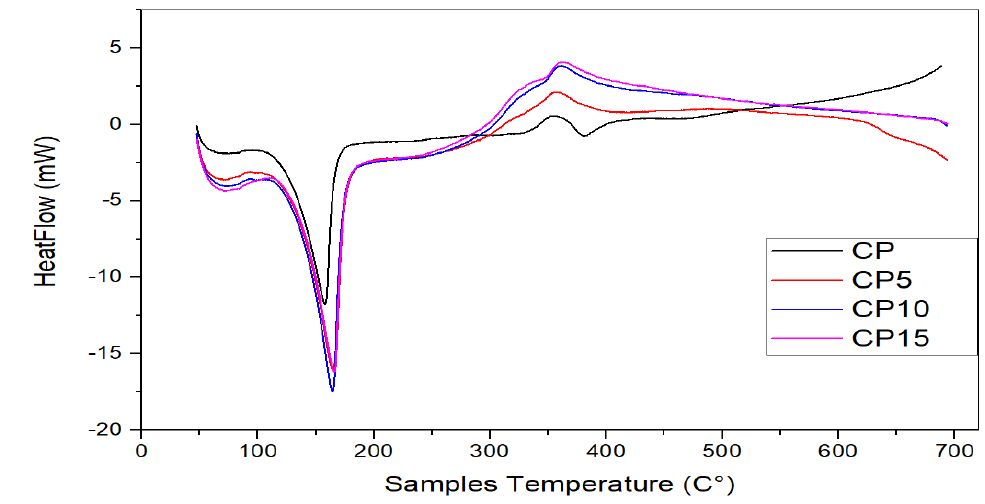
Figure 4. DSC of all